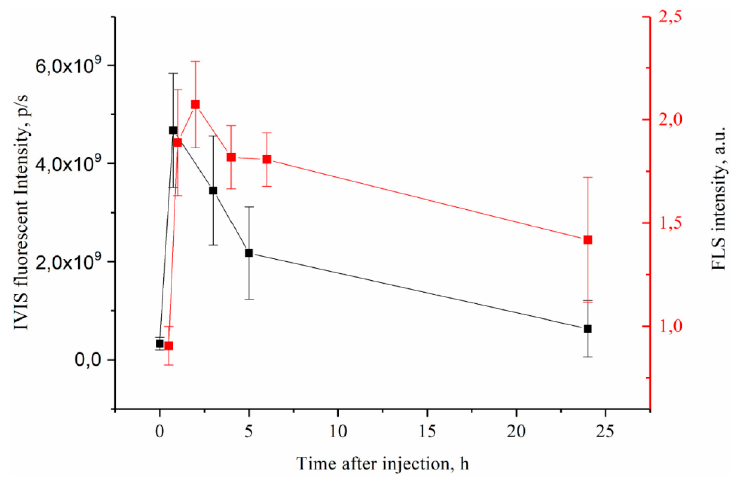
Figure 5. PS accumlation in CT26 tumors after i.v. MNP-HSA@PS injection.